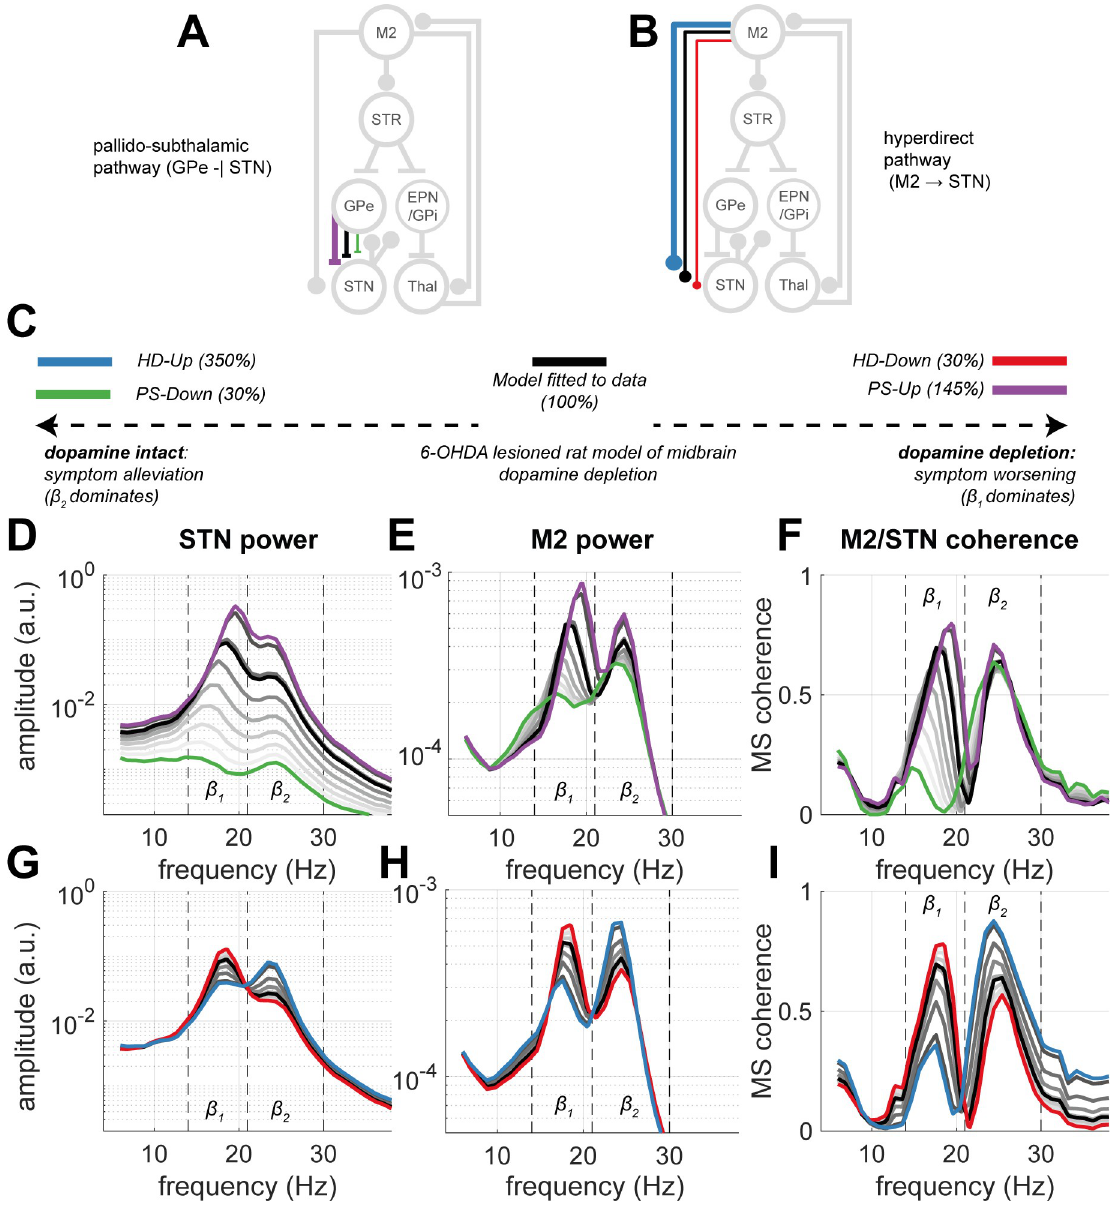
Fig 2. Modulating the strength of inputs to the subthalamic nucleus (STN) from both hyperdirect ( HD ) and pallidosubthalamic ( PS ) pathways leaves distinct spectral features in the oscillatory activity and synchronization of cortex (M2) and STN. Two discrete network states were defined for each pathway: a Down- regulated state fixed at 10% connectivity, as well as an Up- regulated state set at the connection strength eliciting ~200% increase in STN beta power. The fitted model (i.e., the 6-OHDA lesioned state, represented at 100% connectivity) is given in black. (A) Schematic of PS-Up (purple, 145% connection strength) and PS-Down (green, 30% connection strength). (B) Schematic of HD-Down (red, 30% connection strength) and HD-Up (blue, 350% connection strength). (C) Legend to the network states placed on a hypothetical scale from a dopamine intact state associated with a reduction in motor symptoms (far left), to the fitted model (with parameters constrained by data from 6-OHDA rat model of Parkinsonism; middle), to states indicating further progression of the pathology and worsening of motor symptoms (far right). (D) PS network states leave distinct spectral features in the power spectra of STN, with modulation occurring between lower ( β 1 ) and upper beta ( β 2 ) bands. (E) Similar responses can be seen in the M2 power spectra; as well as in (F) the functional connectivity between STN and M2 in terms of the magnitude squared coherence. (G, H, and I) Same as (D, E, and F) but for the HD defined states. Grey lines show the intermediate spectra generated between Up and Down